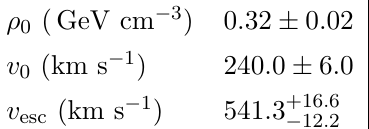
Table 2 . The DM astrophysical nuisance parameters given in ref. [52] which considers the rotation curve of the Milky Way within (cid:24) 100